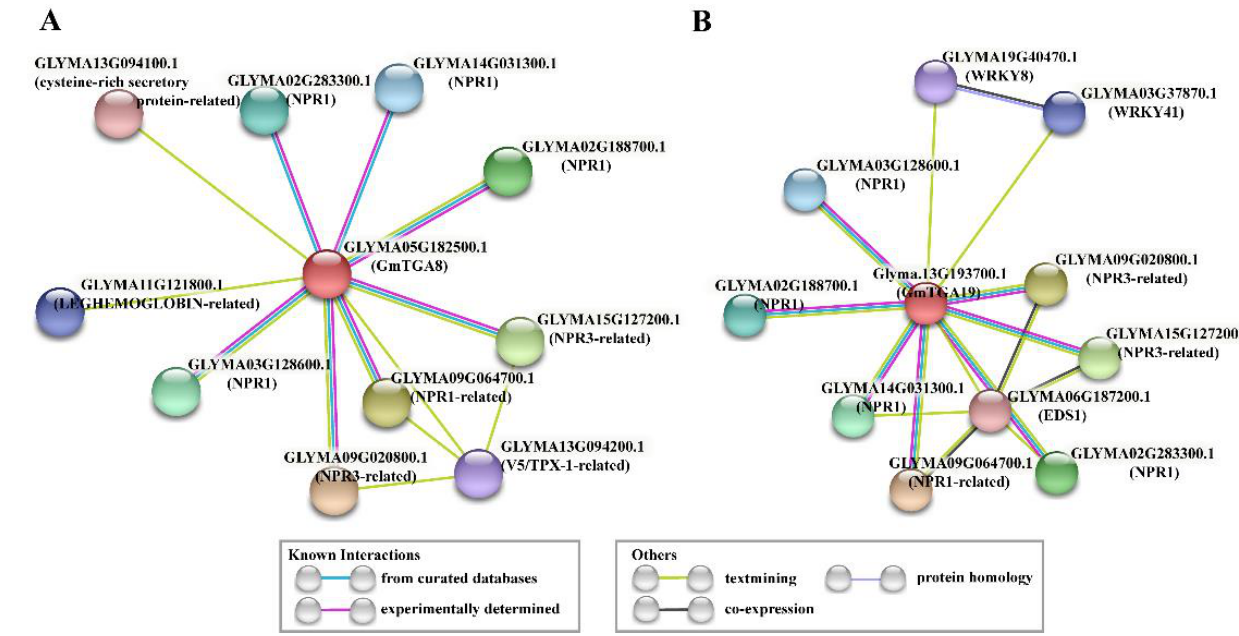
Figure 4. STRING interaction diagram of the analyzed GmTGA 8 (A) and 19 (B) in soybean. Each filled node denotes a gene and protein product of each gene is predicted based on phytozome online database; edges between nodes indicate interactions between protein products. Different edge colors represent the existence of different types of evidence used in predicting the associations. The first shell was set to no more than ten interactors and no interactor was set in second shell.